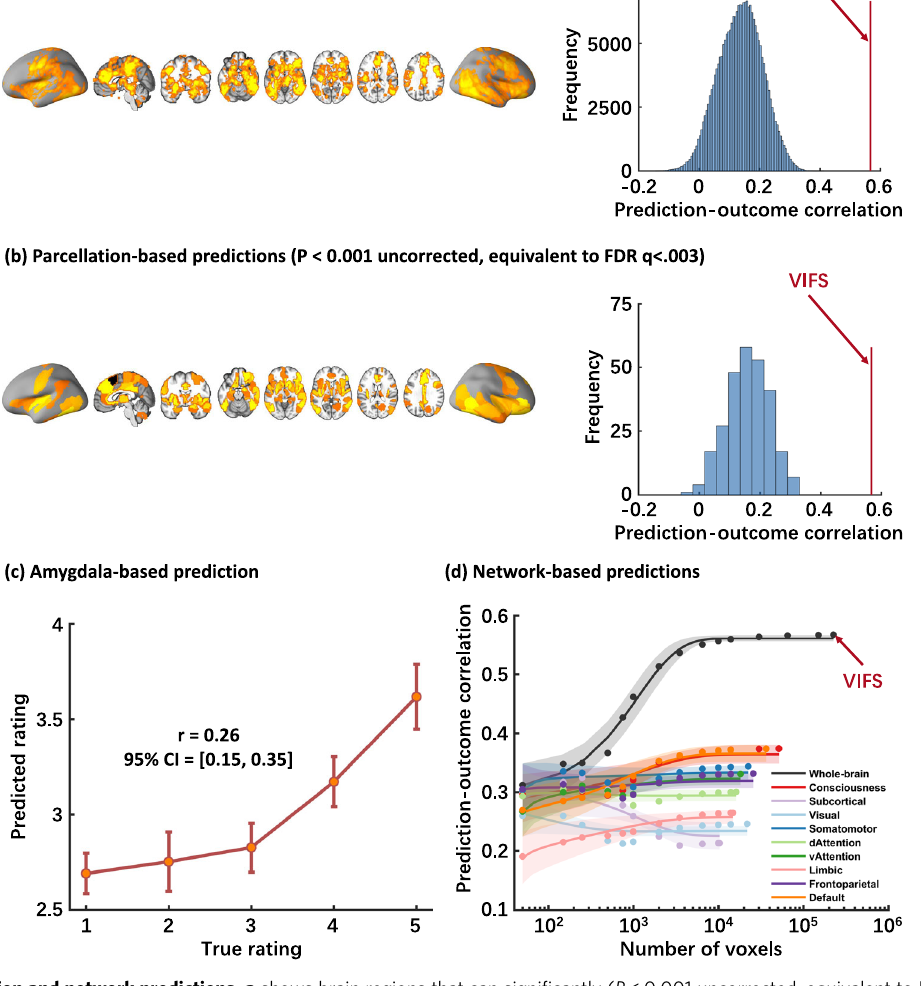
Fig. 4 Local brain region and network predictions. a shows brain regions that can signi fi cantly ( P < 0.001 uncorrected, equivalent to FDR q < 0.004; two- sided) predict subjective fear ratings revealed by searchlight analysis. Histograms: cross-validated predictions (correlations) from local searchlight analysis. Red line indicates the prediction-outcome correlation from VIFS. b depicts brain regions which can signi fi cantly ( P < 0.001 uncorrected, equivalent to FDR q < 0.003; two-sided) predict subjective fear revealed by parcellation-based analysis. Histograms: cross-validated predictions (correlations) from parcellations. Red line indicates the prediction-outcome correlation from VIFS. c shows cross-validated predictions (mean ± SE) from amygdala-based prediction analysis. Error bar indicates standard error of the mean; r indicates overall (between- and within-subjects; i.e., n = 333 pairs) prediction-outcome Pearson correlation coef fi cient. d demonstrates that the information about subjective experience of fear is distributed across multiple systems. Model performance was evaluated as increasing numbers of voxels/features ( x axis) were used to predict subjective fear in different regions of interest including the entire brain (black), consciousness network (red), subcortical regions (light purple) or large-scale resting-state networks. The y axis denotes the cross- validated prediction-outcome correlation. Colored dots indicate the mean correlation coef fi cients, solid lines indicate the mean parametric fi t and shaded regions indicate standard deviation. Model performance is optimized when approximately 10,000 voxels are randomly sampled across the whole-brain. VIFS visually induced fear signature. Source data are provided as a Source Data fi